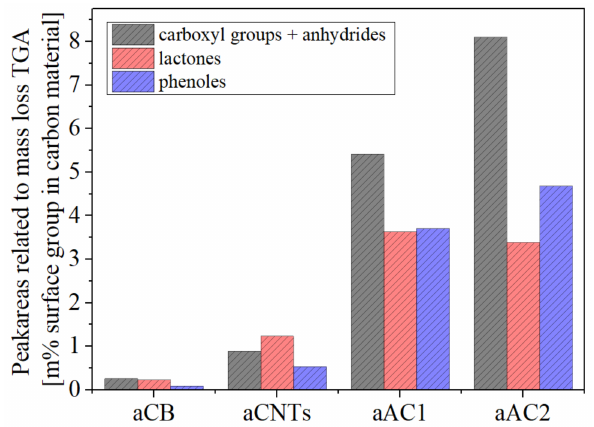
Figure 8. Amount of surface groups determined by gauss functions for CO 2 and CO curves received by TPD (10 K min − 1 ; 20 mL He min − 1 ).